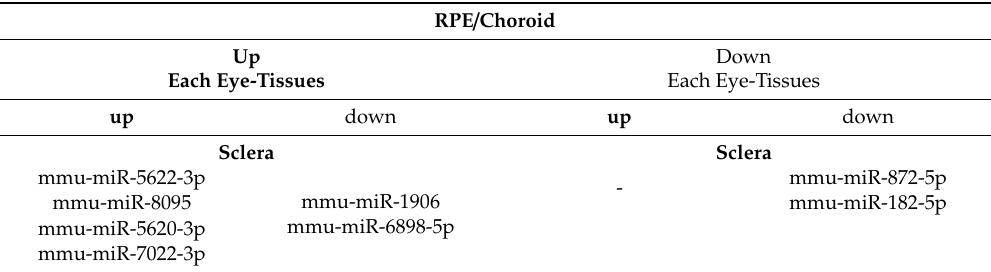
Table 6. Overlapping expression changes in miRNAs in RPE / choroid and other ocular tissues.